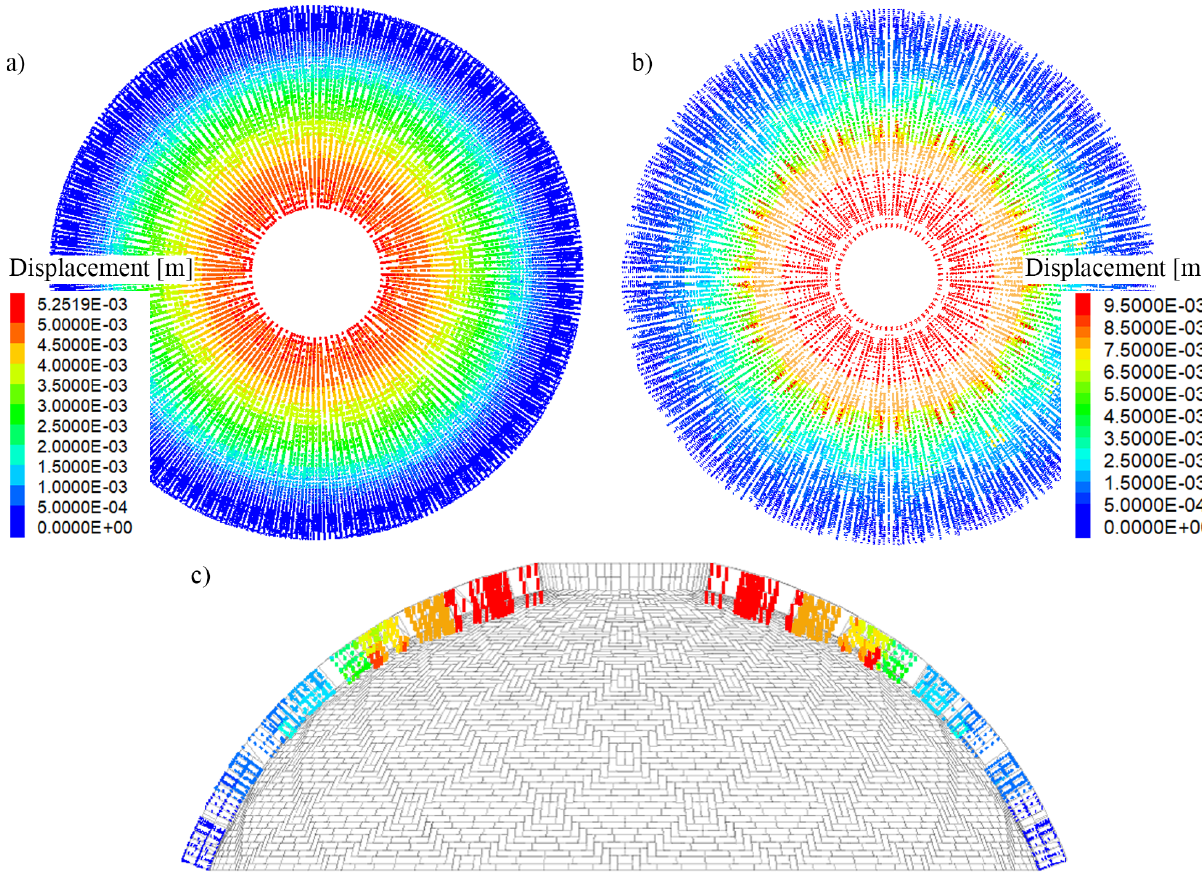
Figure 9: Map of displacement distributions: a) displacements of a dome with common masonry pattern. b) and c) displacements of a dome with cross-herringbone. The complex geometry leads to the sliding of some blocks (displacement 1.0 × 10 −2 meters)